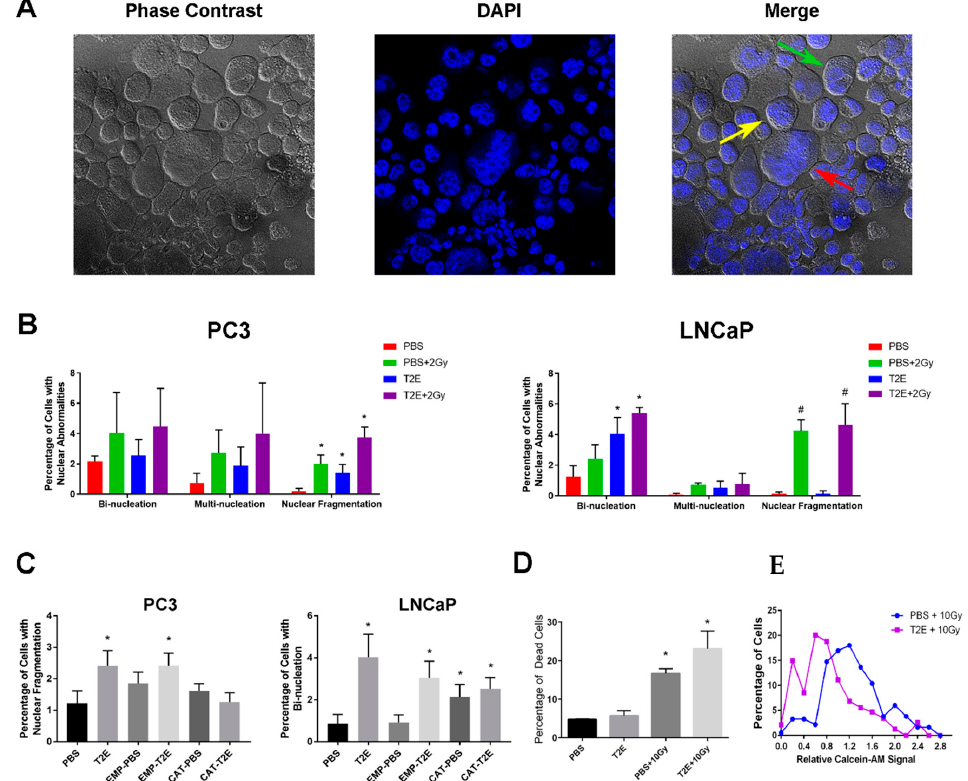
Figure 7. Nuclear abnormalities of prostate cancer cells treated with MnTE-2-PyP and radiation. ( A ) An example of bi-nucleated ( green arrow ), multi-nucleated ( yellow arrow ), and fragmented nucleus ( red arrow ) in PC3 cells. Cells were seeded in PBS or 30 µ M MnTE-2-PyP. After 24 h, 2 or 10 Gy radiation was applied to some groups, and after 72 h, cells were fixed onto slides by cytospin. ( B ) Quantification of nuclear abnormalities in PC3 and LNCaP cells in each condition. ( C ) Quantification of nuclear abnormalities in catalase-transduced PC3 and LNCaP cells with MnTE-2-PyP + radiation treatment. ( D ) Calcein-AM staining for PC3 cells with MnTE-2-PyP and radiation treatment. Percentage of dead cells in each condition after 96 h treatment of PBS or 30 µ M MnTE-2-PyP ± 10 Gy radiation. ( E ) Calcein-AM signal distribution in irradiated PC3 cells with nuclear fragmentation. All data represent mean ± SD from at least three independent experiments. * p < 0.05 compared to PBS treatment; #p < 0.05 compared to PBS + 10 Gy